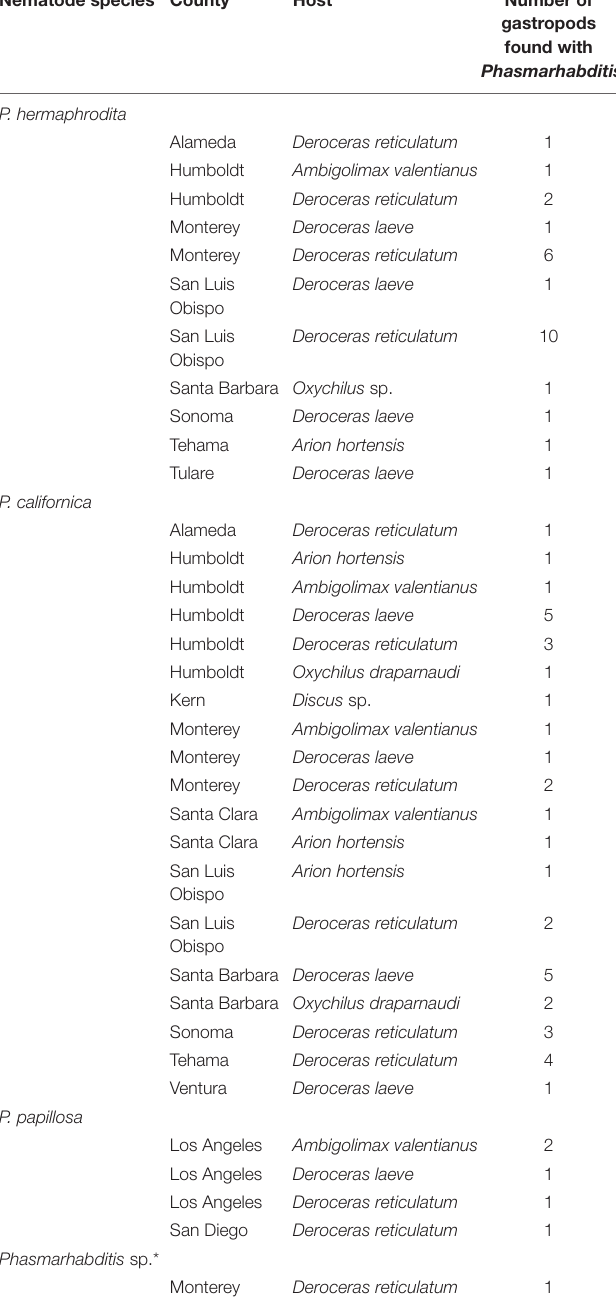
TABLE 2 | Phasmarhabditis species including hosts, sampling locations and morphological/genetic characterization from surveys performed between 2012 and